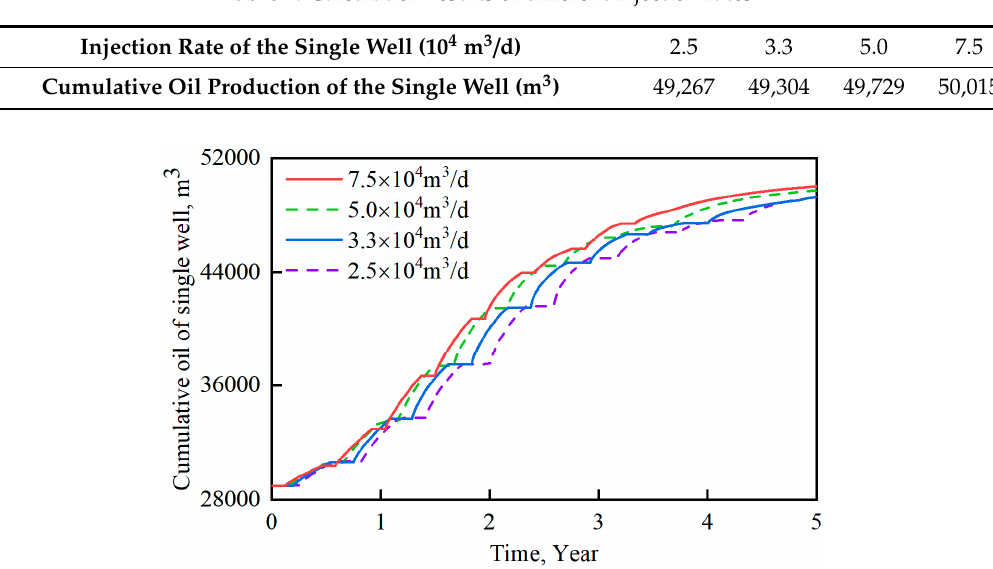
Figure 9. Comparison of cumulative oil production of the single well in each scheme under different CO 2 injection rates.